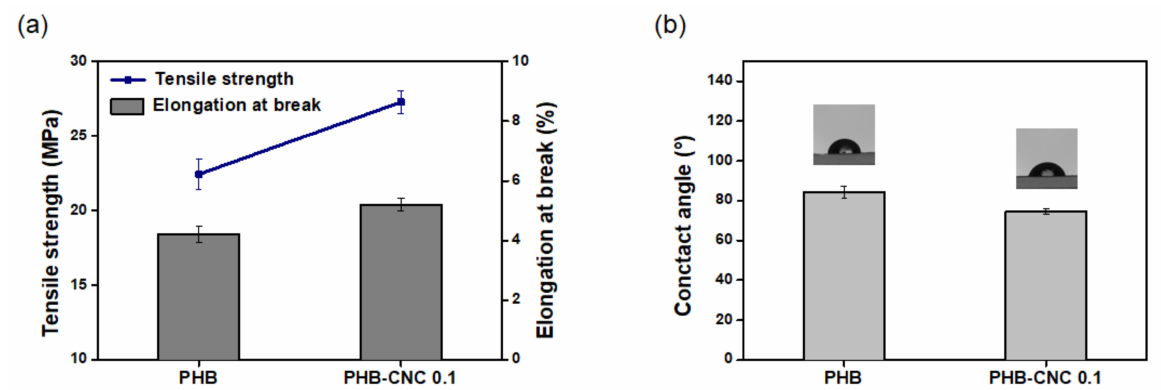
Figure 4. ( a ) Tensile strength and elongation at break, ( b ) water contact angle of PHB and PHB-CNC nanocomposite (0.1 g/L